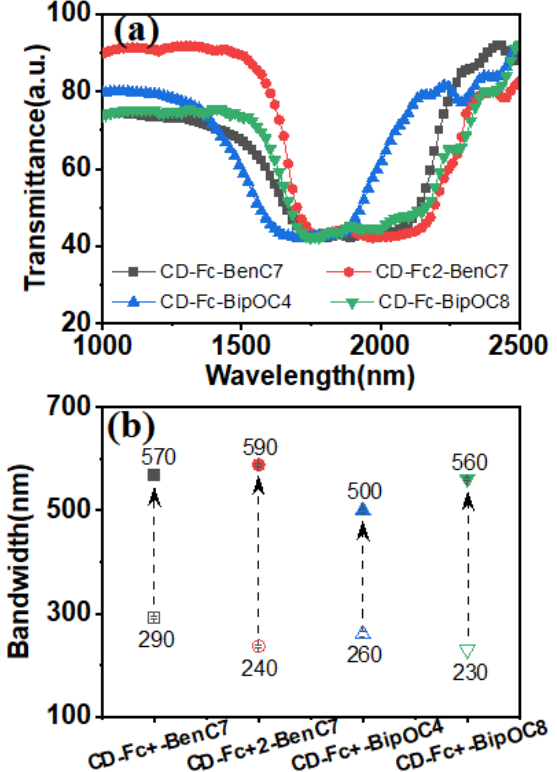
Figure 4. ( a ) UV transmission spectra ( b ) electronically controlled reflective bandwidth of LC samples doped with CD-Fc + of different structures.